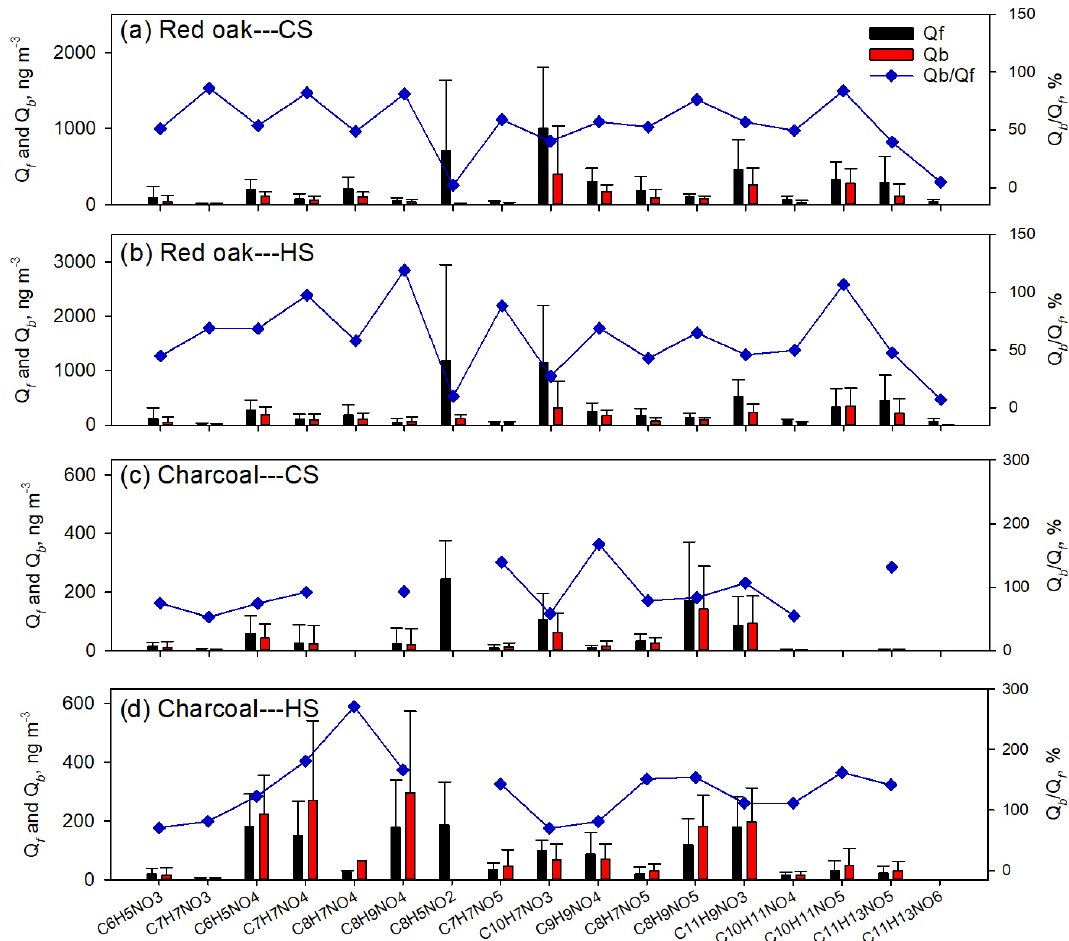
Figure 1. Average concentrations of individual NACs in Q f and Q b samples for (a) red oak burning in the CS phase, (b) red oak burning in the HS phase, (c) charcoal burning in the CS phase, and (d) charcoal burning in the HS phase. The blue scatters in each plot are Q b -to- Q f mass ratios of individual NACs ×